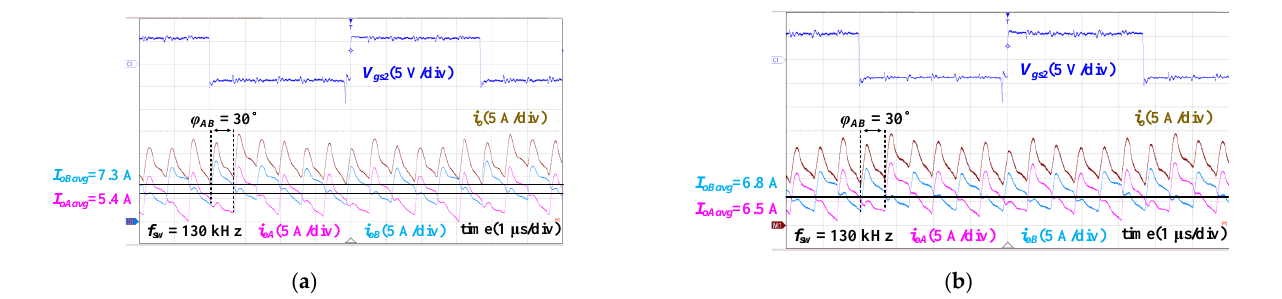
Figure 22. Output current waveforms of two modules in parallel at a 25% load:( a ) without a current sharing control, ( b ) with a current sharing control.